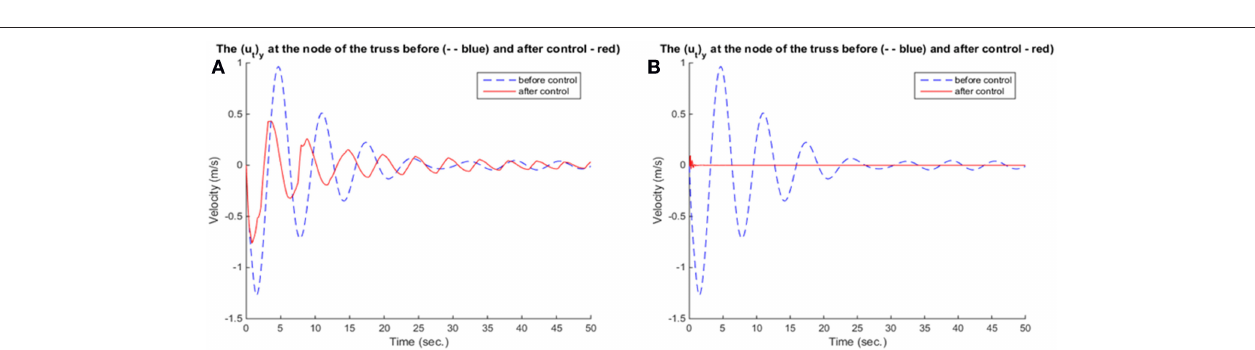
FIGURE 8 | Displacement of node 16 for (A) fuzzy controller and (B) neuro-fuzzy controller.